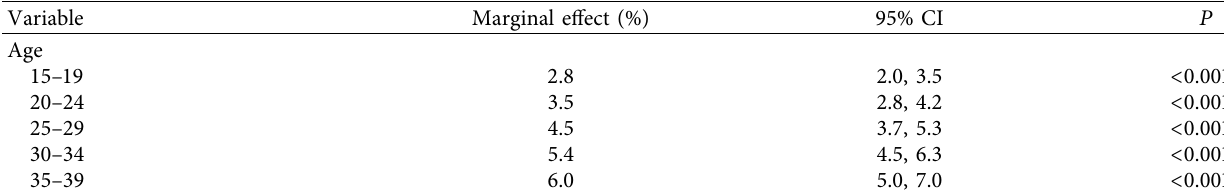
Table 2: Marginal predictive model of the factors associated with renal